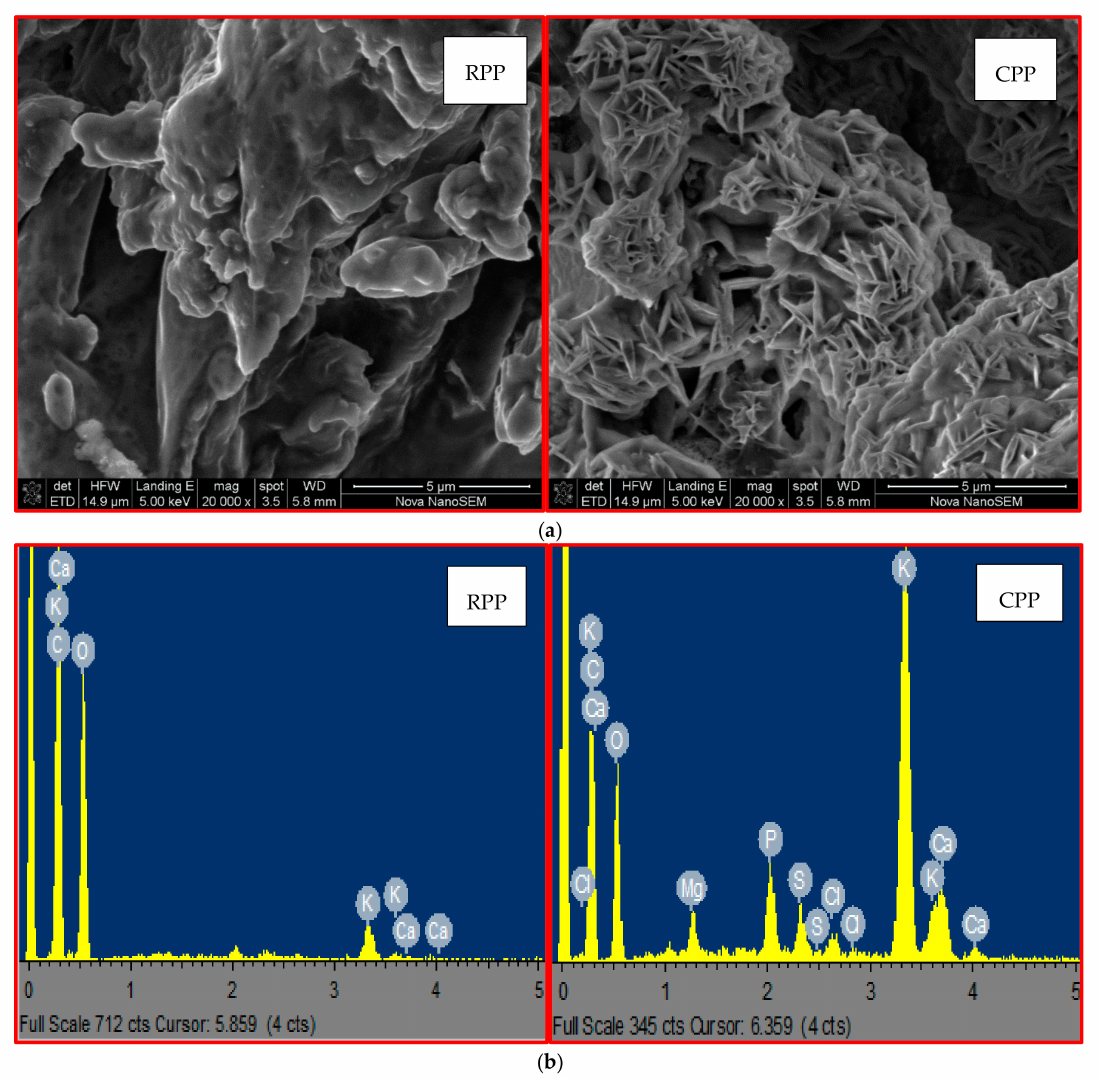
Figure 2. Plots of ( a ) SEM and ( b ) EDX images of RPP and CPP (at 600 ◦ C)